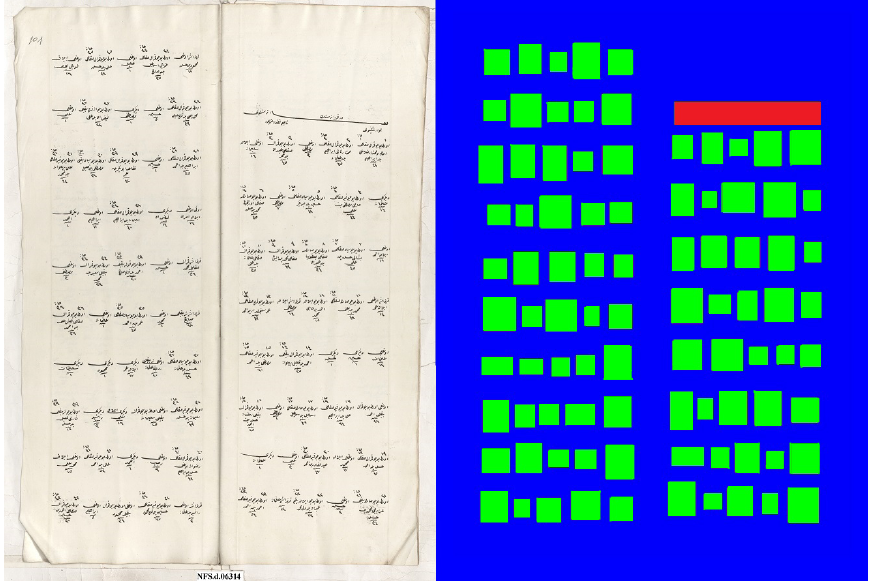
Figure 4. A sample register page and its labeled version are demonstrated. Different colors represent different object types. The background, which is the region between the objects and document borders, is marked with blue. The start of a populated place object is colored with red. The individual objects are marked with